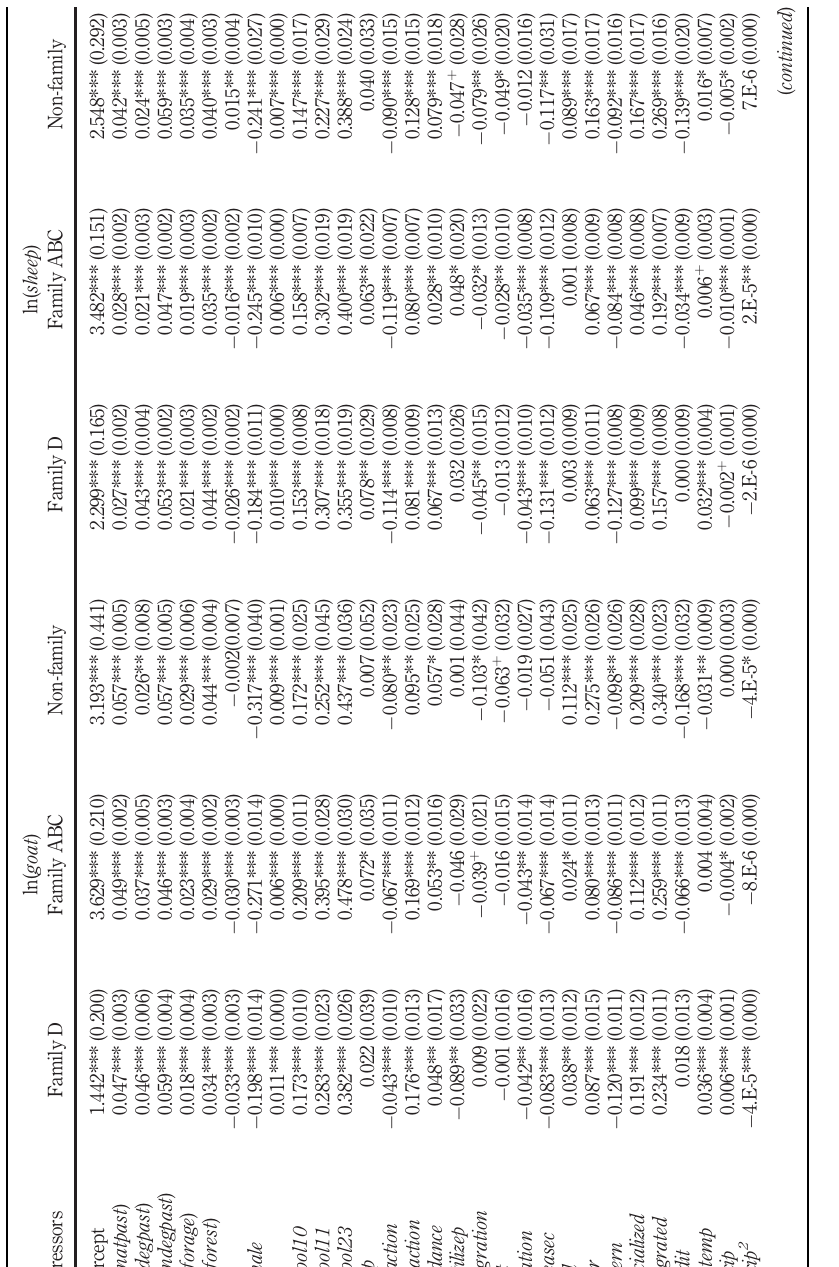
Table IV. Maximum